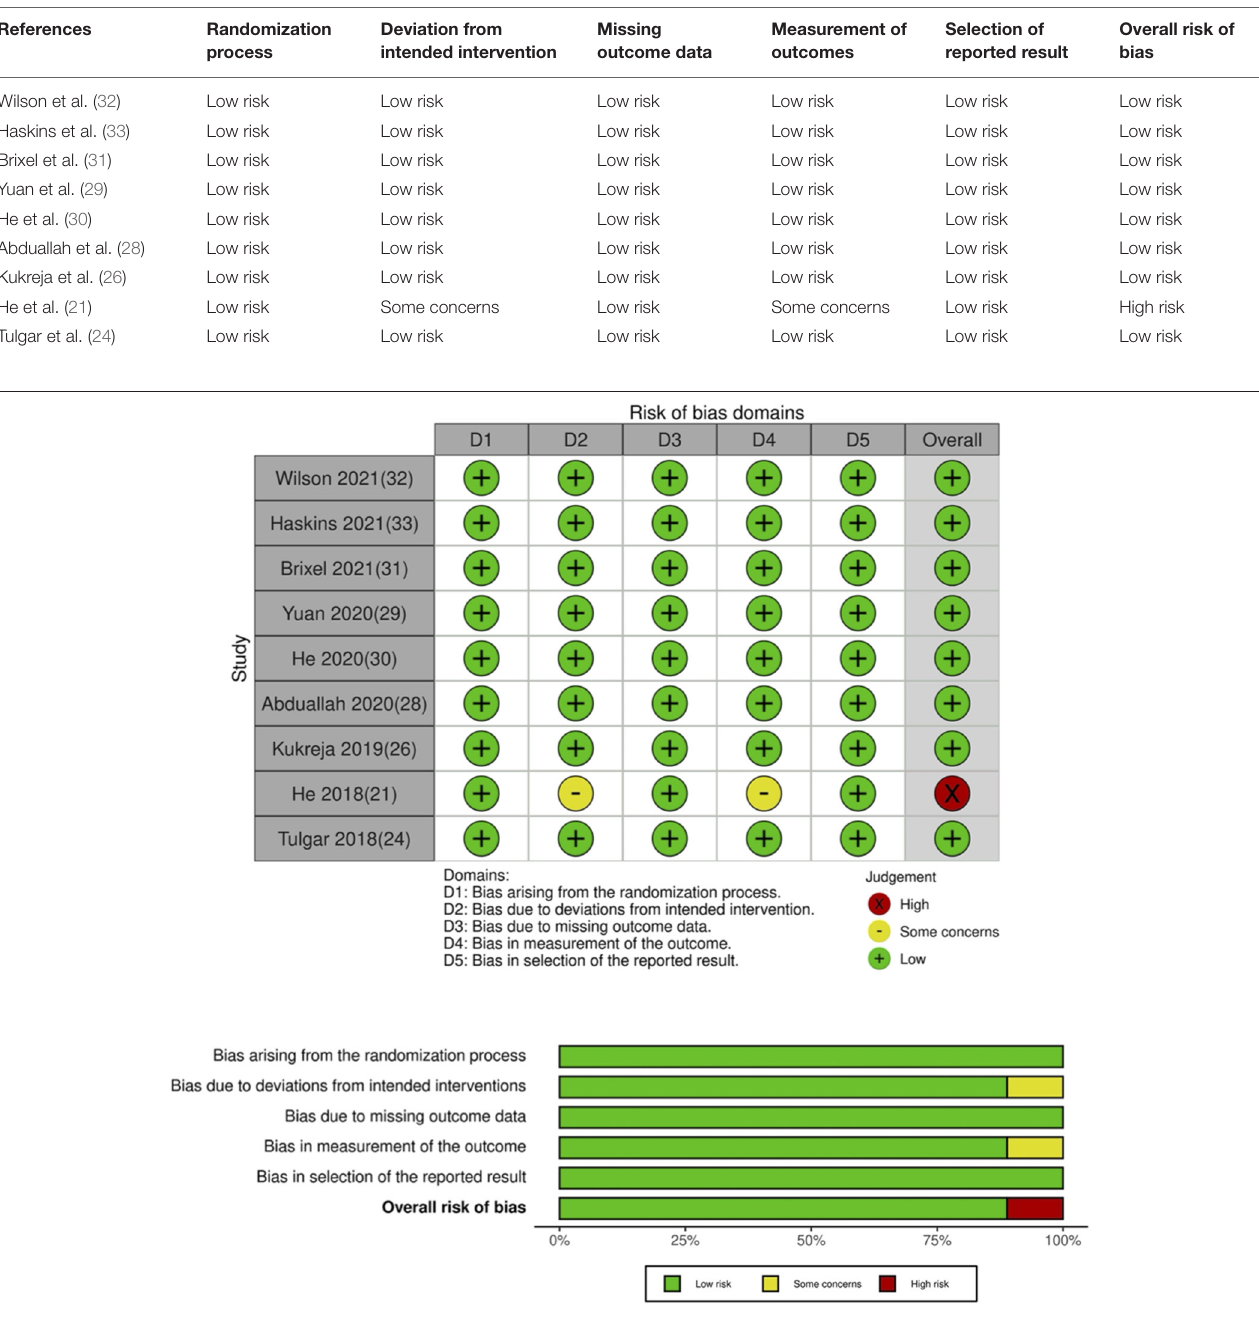
FIGURE 2 | Risk of bias plot for